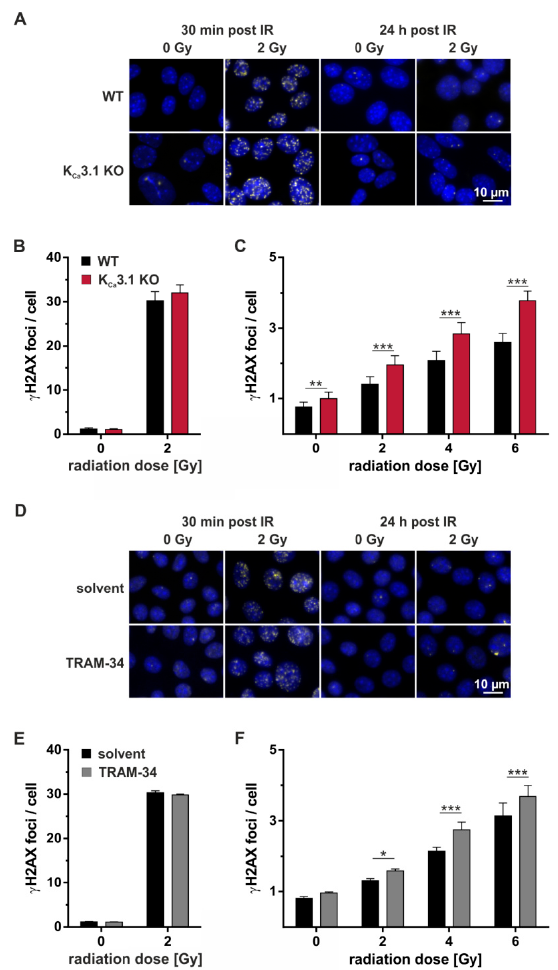
Figure 4. K Ca 3.1 channels promote repair of DNA double-strand breaks. ( A ) Fluorescence micrographs showing nuclear γ H2AX foci as a measure of DNA double-strand breaks 30 min (left) and 24 h (right) after irradiation of MMTV-PyMT WT (upper row) and K Ca 3.1 KO cells (lower row) with 0 Gy or 2 Gy. ( B,C ) Mean number (± SE, n = 7) of nuclear γ H2AX foci in MMTV-PyMT WT (black) and K Ca 3.1 KO (red) cells ( B ) 30 min and ( C ) 24 h after irradiation. ( D ) Fluorescence micrographs showing nuclear γ H2AX foci 30 min (left) and 24 h (right) after irradiation of MMTV-PyMT WT with 0 Gy or 2 Gy. Irradiation and 24 h post-incubation were either performed in the absence (solvent, upper row) or presence (lower row) of TRAM-34 (10 µM). ( E,F ) Mean number (± SE, n = 5) of nuclear γ H2AX foci in MMTV-PyMT WT cells (E) 30 min and (F) 24 h (red) after irradiation and post-incubation in the absence (black bars) or presence (gray bars) of TRAM-34 (10 µM). γ H2AX foci in ( A,D ) are shown in yellow, DAPI-stained nuclei appear in blue. *, **, and *** indicate p ≤ 0.05, p ≤ 0.01, and p ≤ 0.001, respectively, two-way ANOVA with Sidak’s post-hoc test.